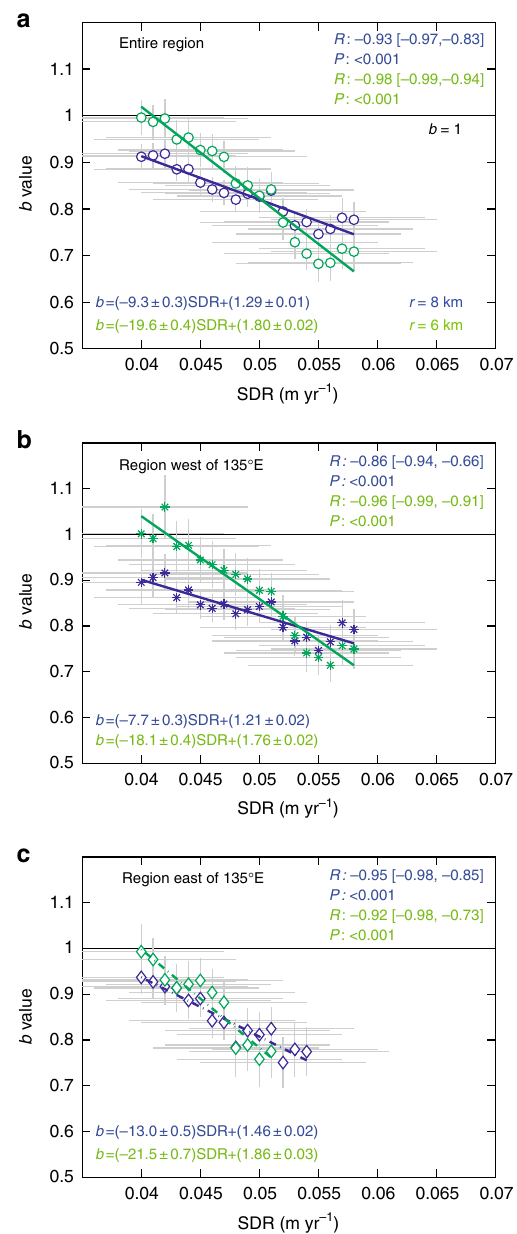
Fig. 2 Plot of b values as a function of SDR. Horizontal and vertical bars in gray indicate sliding windows (width of 0.014 m year − 1 ) and bootstrapping errors, respectively. The error bars represent one standard deviation of a bootstrap sampling distribution. We used radii: r = 6 and 8 km in green and blue, respectively. The least-square regression lines are provided in the corresponding color. R : correlation coef fi cient with the lower and upper bounds in brackets for a 95% con fi dence interval for the coef fi cient, P : P - value of a signi fi cant test. We divided a the entire region into b the region west of 135°E, and c the region east of